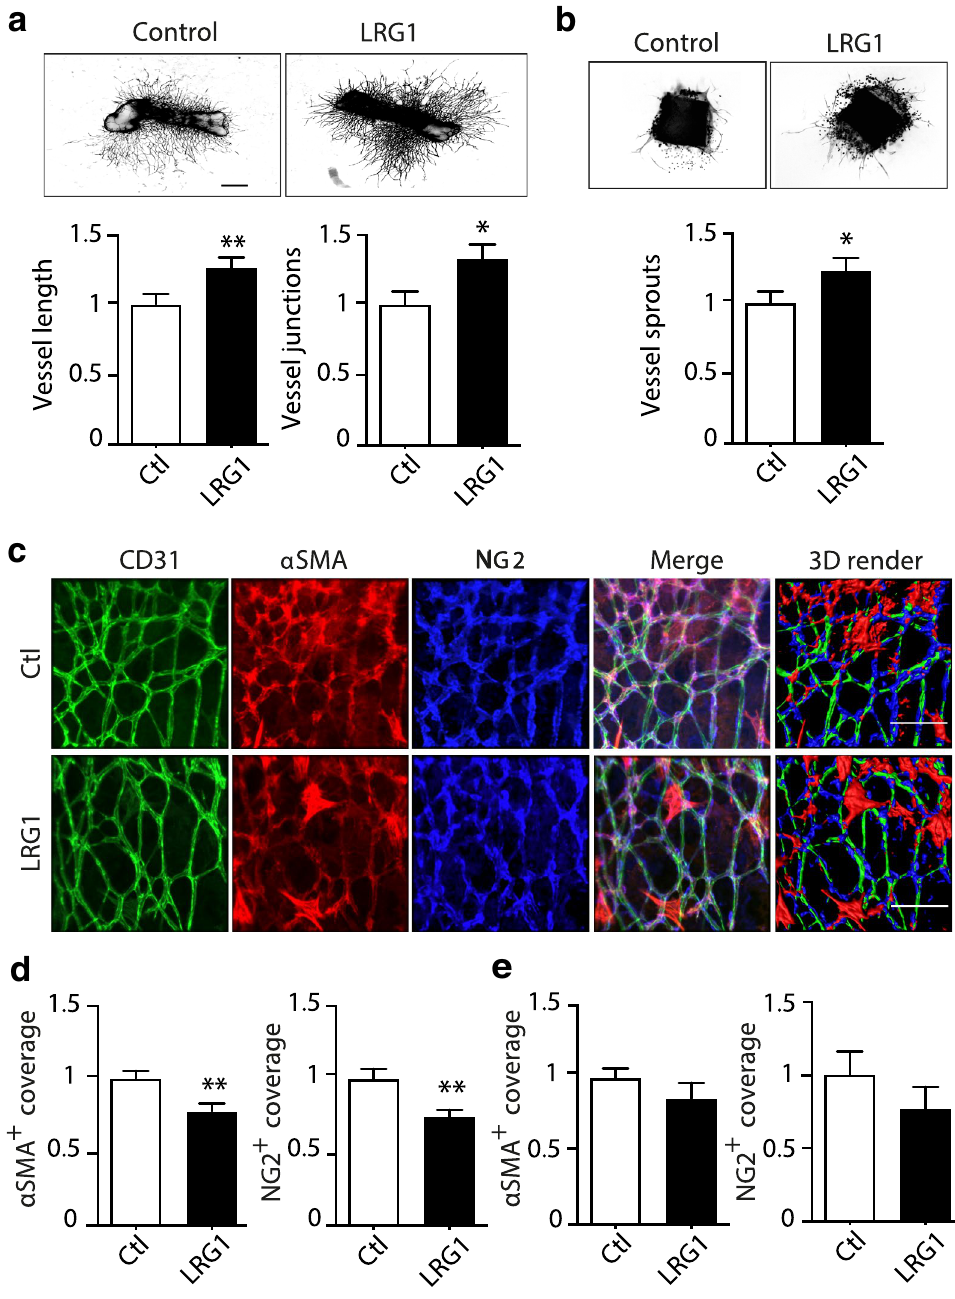
Figure 1. LRG1 treatment induces angiogenesis with reduced mural cell coverage. Mouse metatarsal bones ( a ) and aortic rings ( b ) were treated with PBS as control (Ctl) or 70 μg/ml recombinant human LRG1 and analysed for angiogenesis and sprouting respectively. ( c , d ) Representative images of metatarsal bones treated with PBS as control (Ctl) or 70 μg/ml LRG1 and stained with antibodies against CD31 (green), NG2 (blue), and αSMA (red) for mural cell coverage and analysis. ( e ) Mural cell coverage analysis for aortic rings. Scale bars, 50μm. N ≥ 3 independent experiments. Student’s t-test, Mean ± SEM, * ≤ 0.05, ** ≤